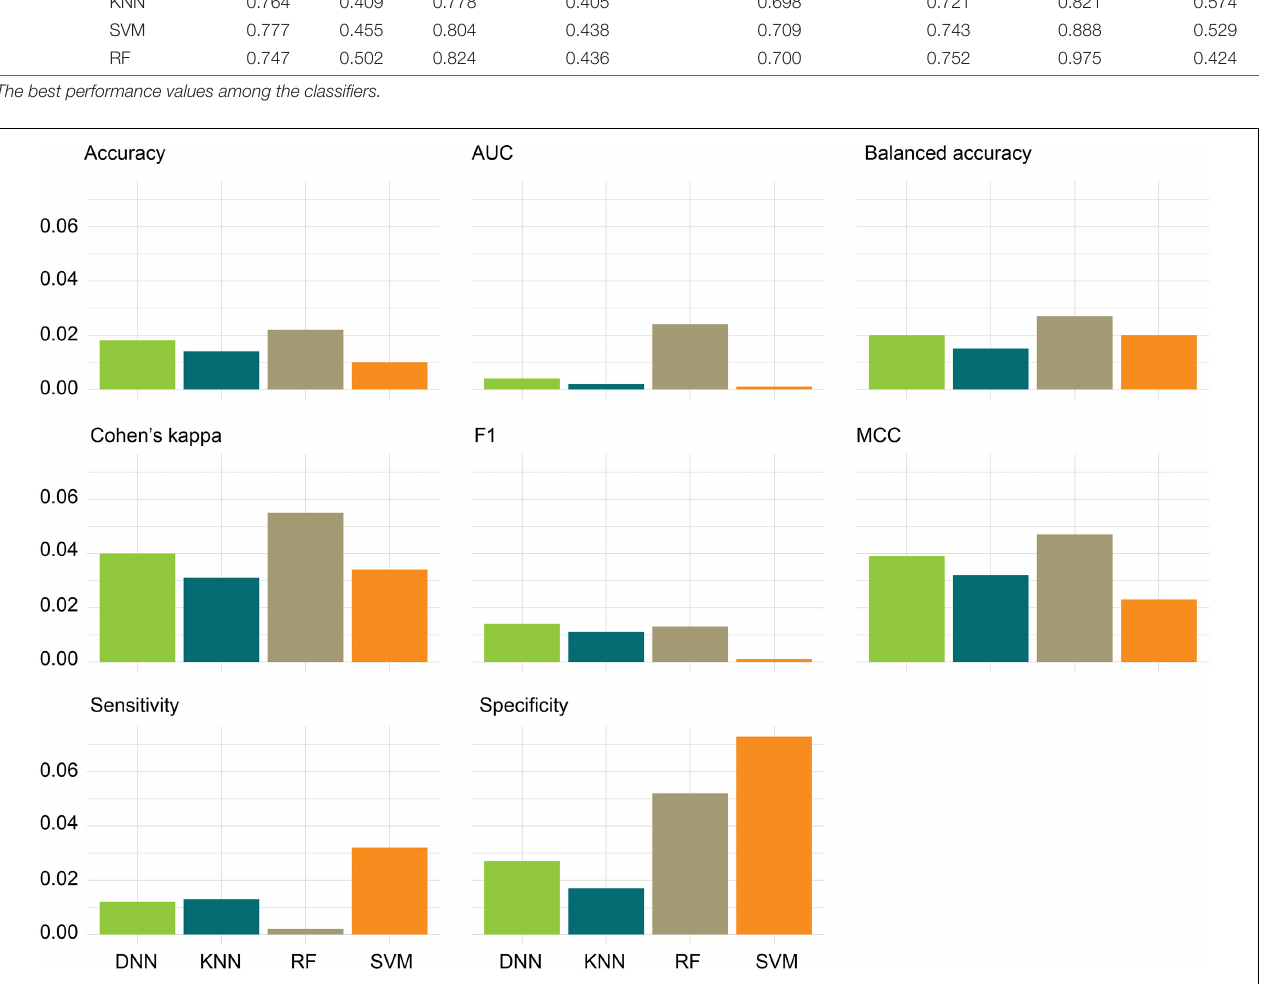
FIGURE 4 | Absolute differences, | MCCV-IV|, of the four performance metrics: absolute differences of the eight performance metrics between the 100-iteration MCCV and the independent validation (IV) set were calculated for the four